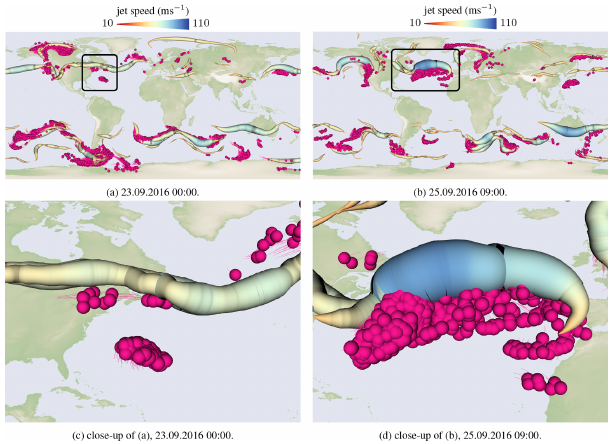
Figure 10. Visualization of jet streams C (t) and WCB particles W ∗ (t) . Panel (a) shows a WCB outflow moving northwards in di- rection of the jet stream. Panel (b) shows the situation 2d later. The WCB approached the jet stream and a considerable acceleration of the wind speed at the jet core is observable (dark blue jet). For both images, close-ups are shown in panels (c) and (d) . Jet speed is mapped to tube color and tube